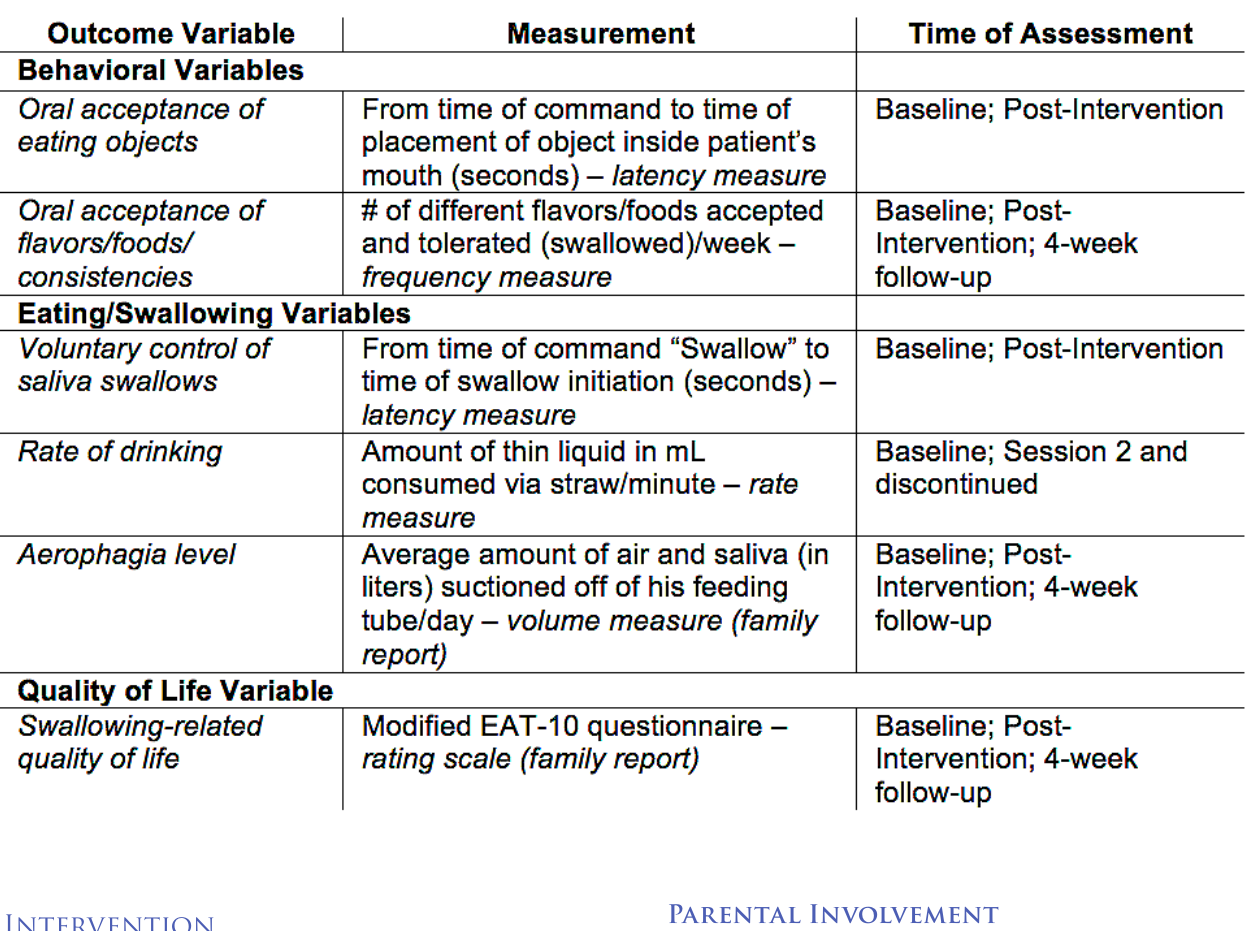
Table 1. Outcome Variables, Assessment Measurements, and Time of